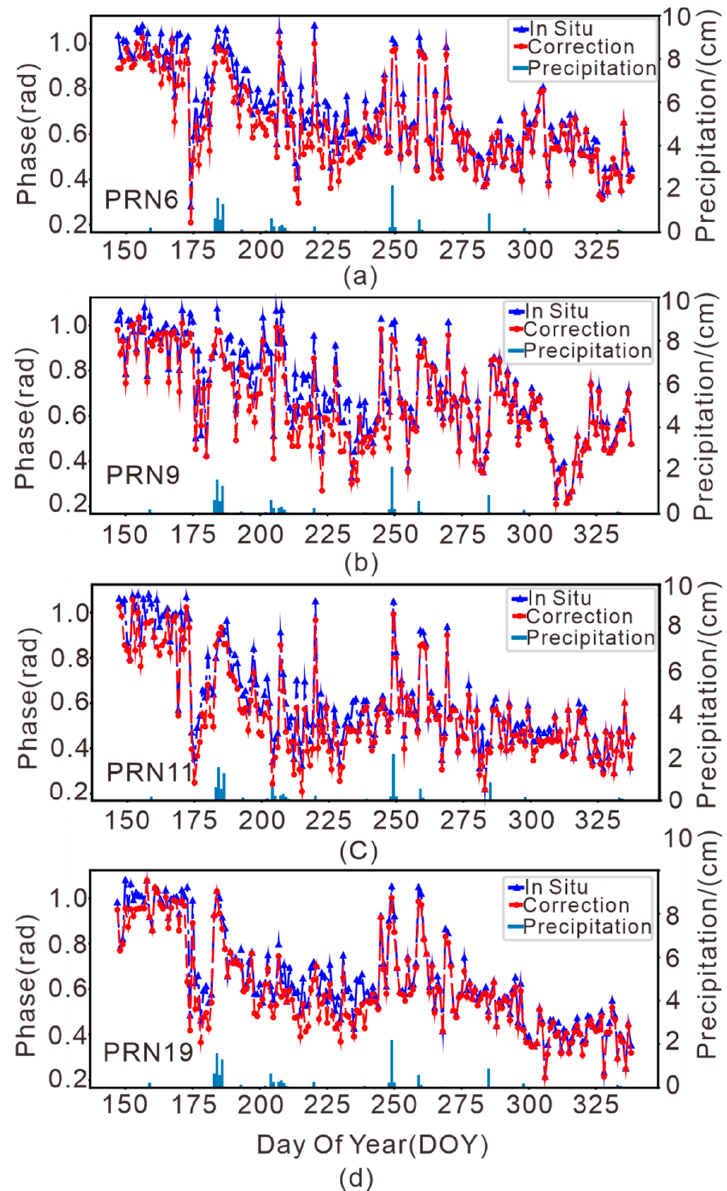
Figure 6. ( a ) PRN 6 reflection signal delay phase correction diagrams. ( b ) PRN 9 reflection signal Figure 6. (a) PRN 6 reflection signal delay phase correction diagrams. (b) PRN 9 reflection signal 317 delay phase correction diagrams. ( c ) PRN 11 reflection signal delay phase correction diagrams. delay phase correction diagrams. (c) PRN 11 reflection signal delay phase correction diagrams. (d) 318 ( d ) PRN 19 reflection signal delay phase correction PRN 19 reflection signal delay phase correction diagrams. 319